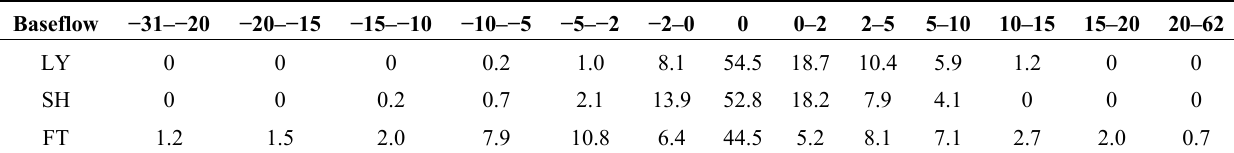
Table 13. Statistic distribution of baseflow variation in Scenario S1-S0 (area percentage, %). Baseflow